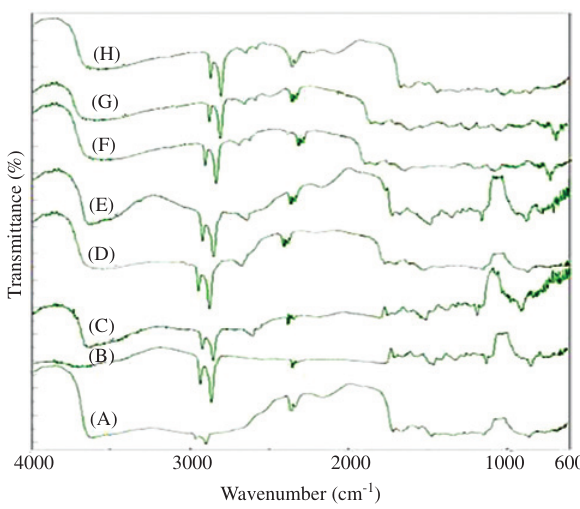
Figure 3: FTIR spectra of PVA/( x )MWCNTs(15- x )ZnO for (A) pure PVA, (B) x = 0 wt%, (C) x = 1 wt%, (D) x = 5 wt%, (E) x = 7.5 wt%, (F) x = 10 wt%, (G) x = 14 wt% and (H) x = 15 wt%.